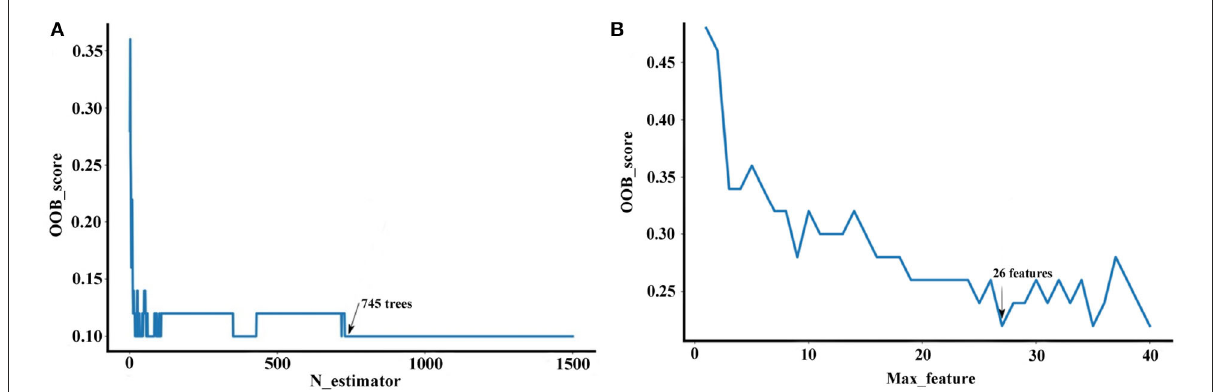
FIGURE7 The parameter selection of the RF model (Description: (A) represents the parameter selection approaches for the n-estimator; (B) represents the parameter selection approaches for max_feature. These parameter selection were performed according to OOB error, which can guarantee an excellent predicted and generalization ability for the developed RF